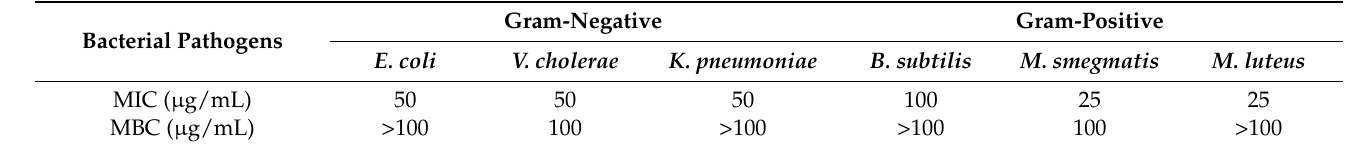
Table 2. MIC and MBC values for PoAgNPs against bacterial pathogens. Bacterial Pathogens